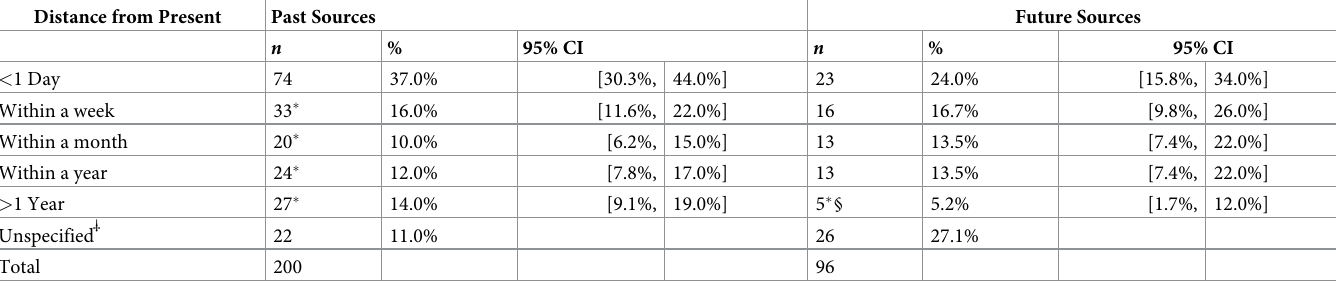
Table 2. Temporal origin of episodic sources in content-filled reports.